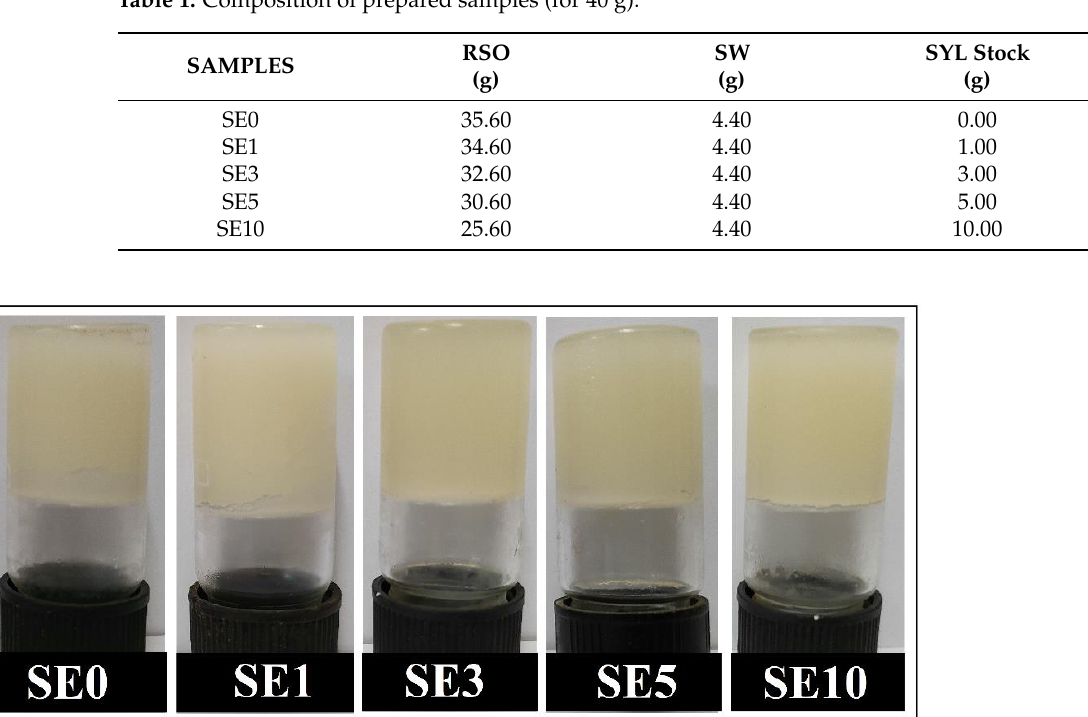
Table 1. Composition of prepared samples (for 40 g).